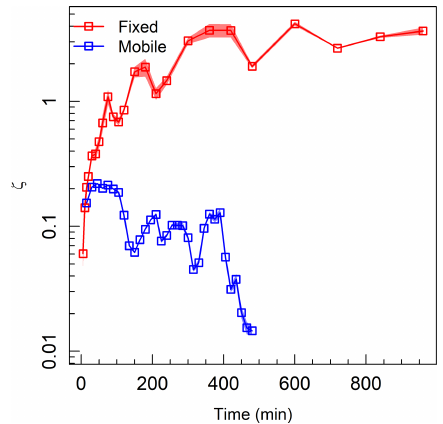
Figure 6. Throughput ratio ( ζ ) calculated as the ratio of the vol- umes of sediment transport and morphologic